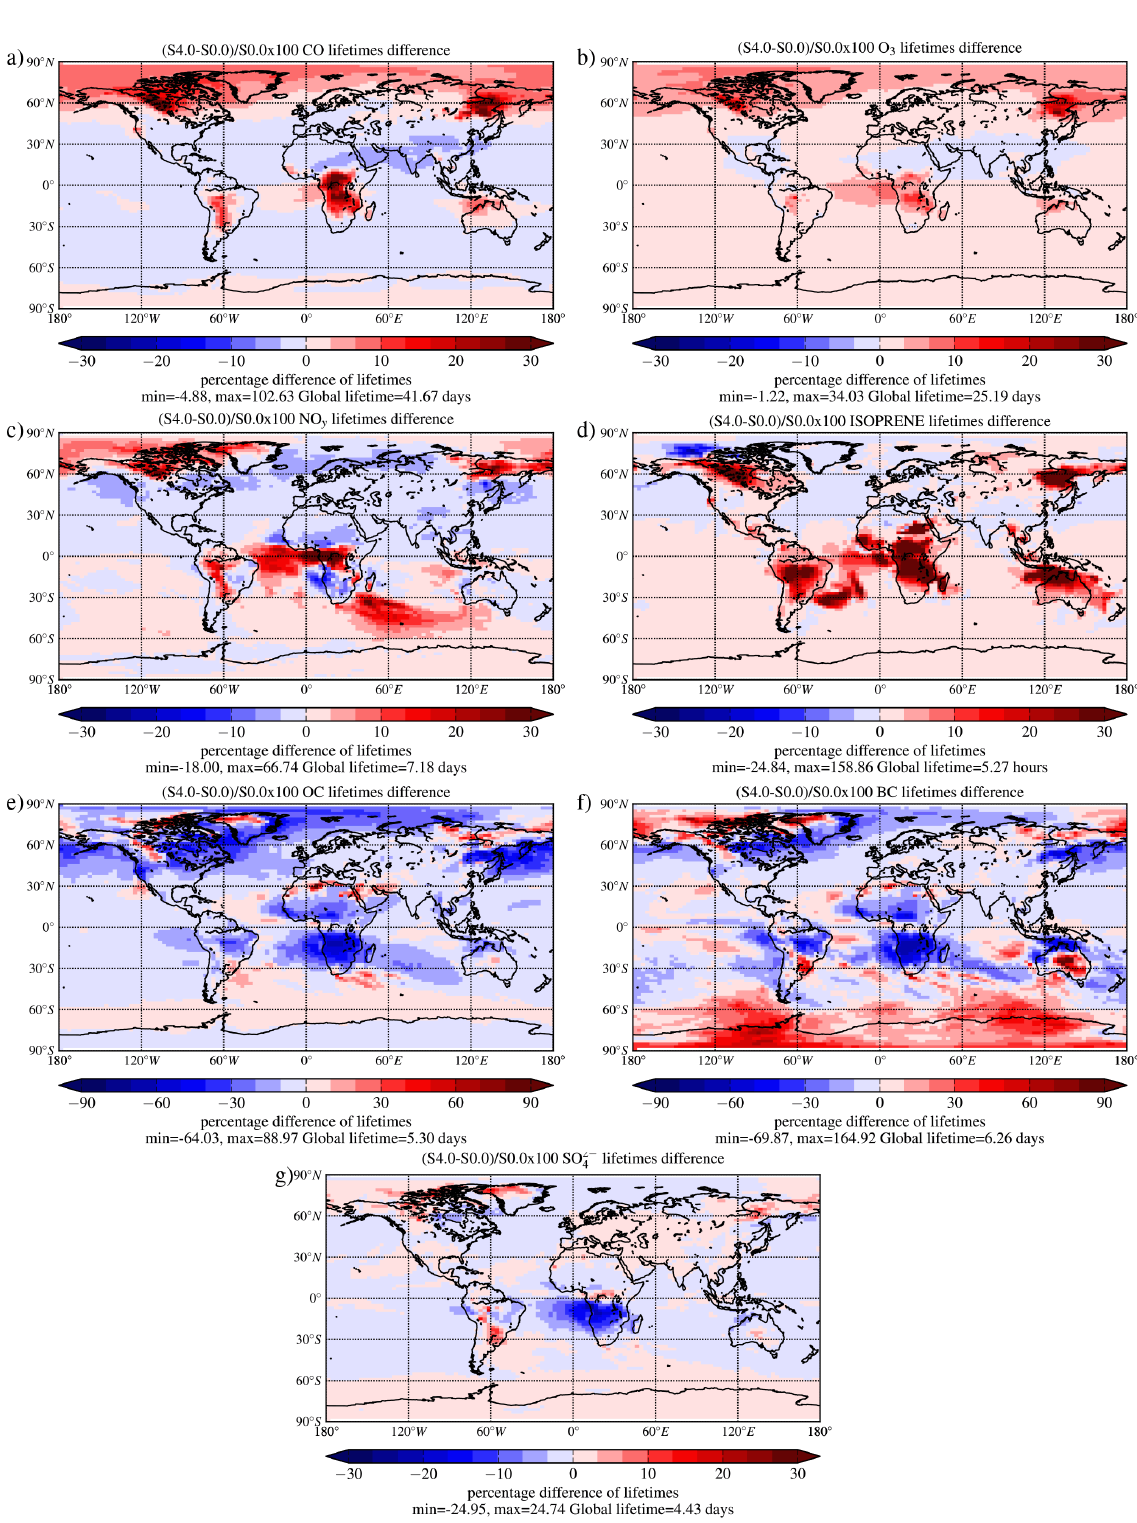
Figure 10. Percentage of impact of wildfire emissions on the computed annual mean tropospheric lifetimes of CO (a) , O 3 (b) , NO y (c) , isoprene (d) , OC (e) , BC (f) and SO 2 − (g) depicted as the percentage difference of S4.0 and S0.0. The color bar ranges from − 30 to 30% 4 ( − 90 to 90% for OC and BC). The minimum and maximum local lifetime percentage changes as well as the global lifetime are printed below each